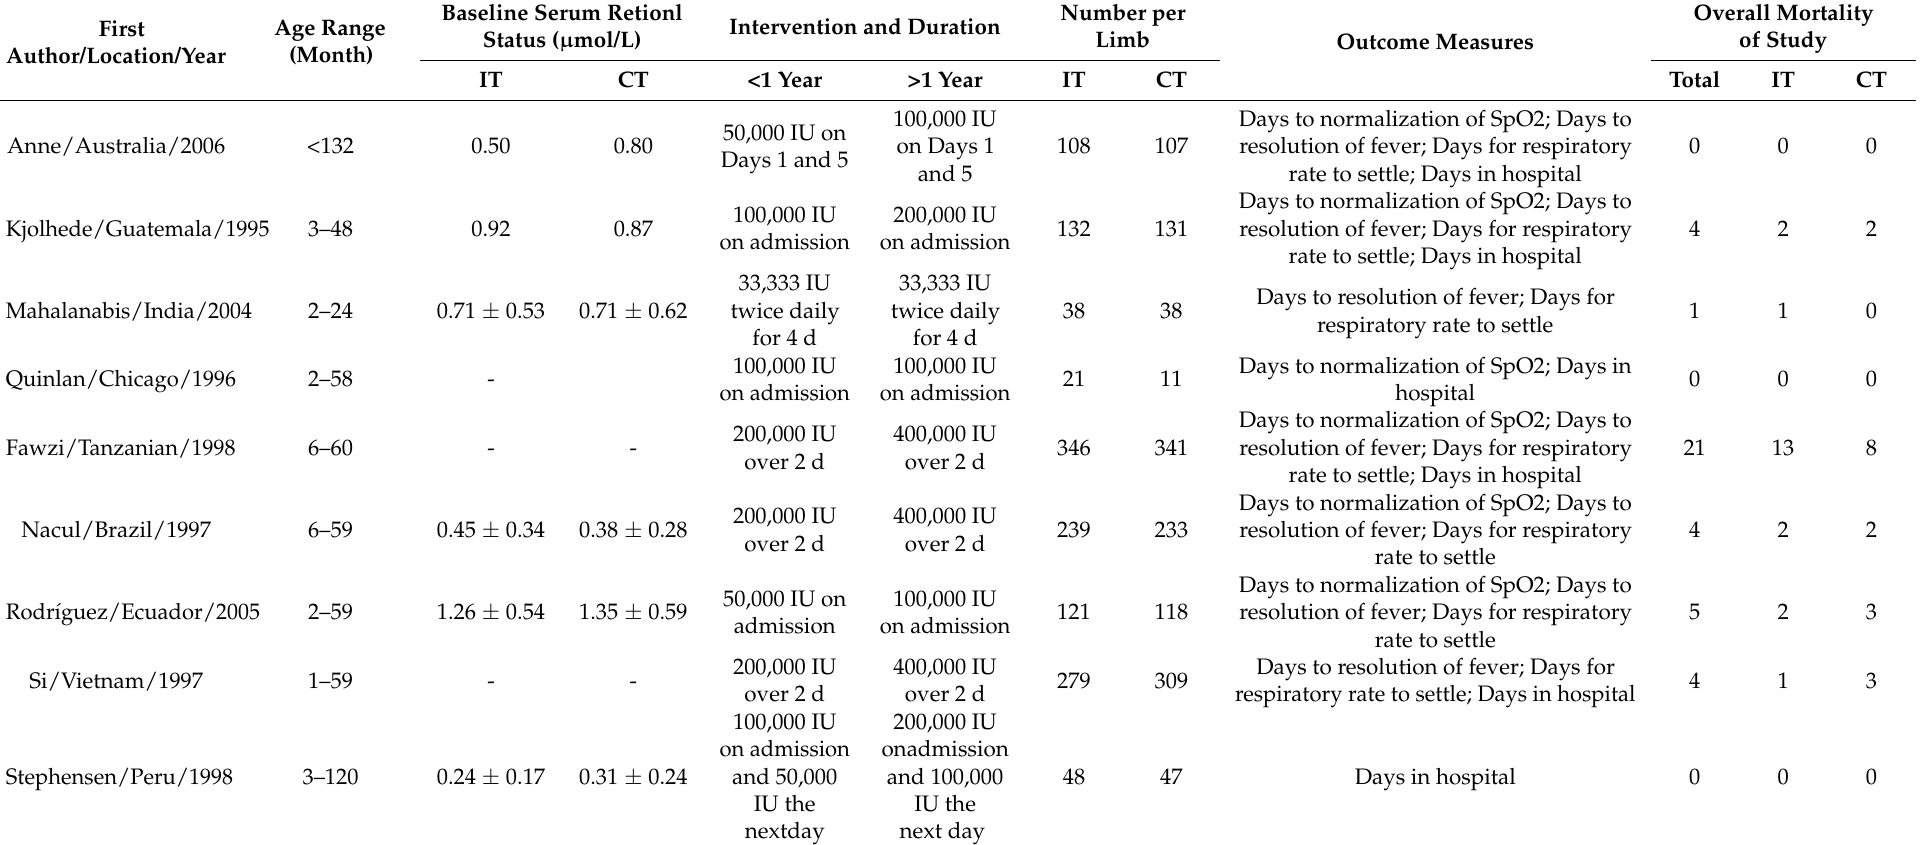
Table 1. Characteristics of the included